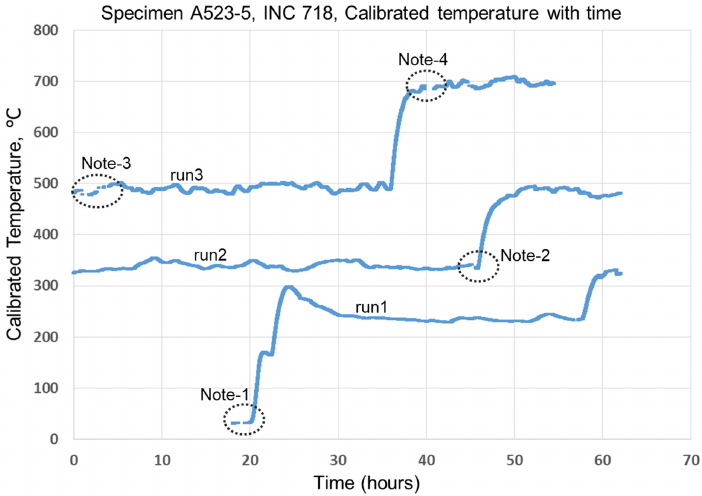
Figure 13. Calibrated temperature measurement using embedded FBG sensor on INC 718 specimen A523-5. (Note-1: fixing cable connections during startup; Note-2, Note-3: data interruption due to loose cable connection; Note-4: sensor malfunctioning due to temporary loss of signal strength.)